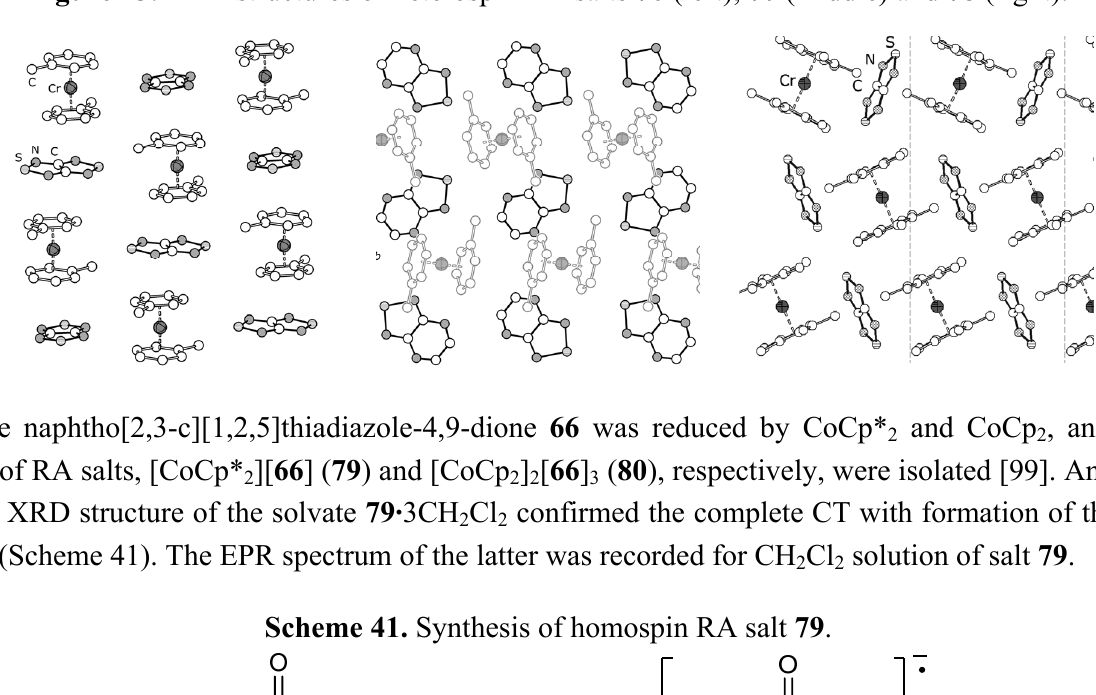
Figure 13. XRD structures of heterospin RA salts 76 (left), 77 (middle) and 78 (right).